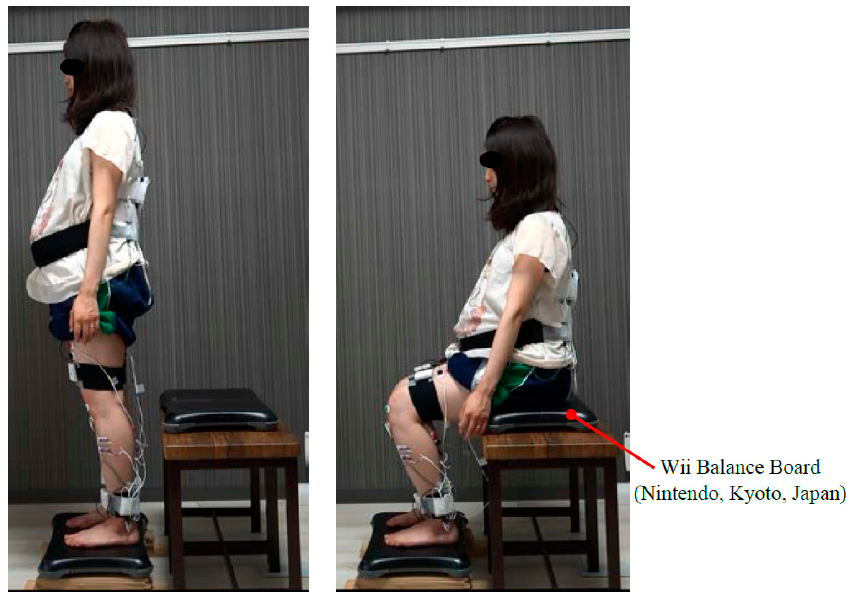
Figure 3. Experimental